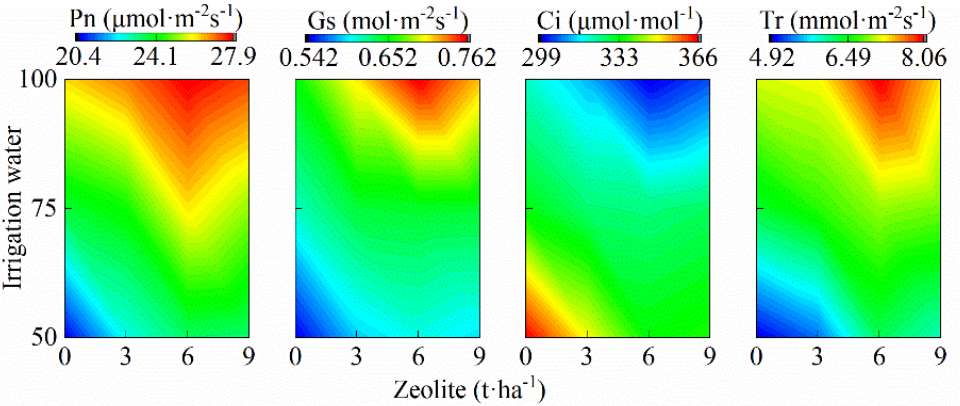
Figure 3. Effects of W-Z on tomato physiological indexes during alternate drip irrigation under mulch. Pn , Gs , Ci , and Tr represent photosynthetic rate, stomatal conductance, intercellular CO 2 concentration, and transpiration rate, respectively.